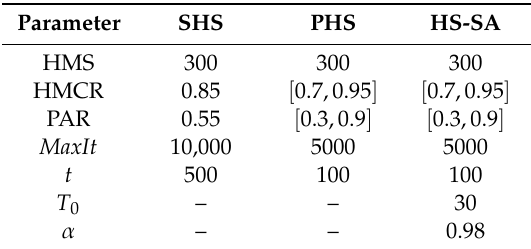
Table 2. Table 1. Parameters Setting for SHS, PHS, and